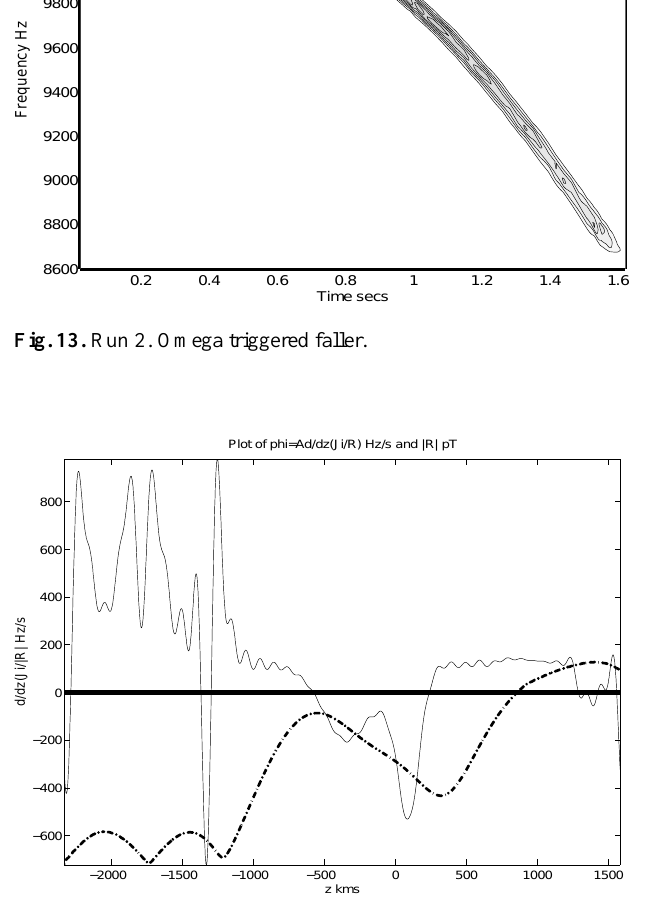
Fig. 14. Run 2. Plot of wave profile R = | E | (dashed line) and 8 (solid line) as functions of z at t = 1 . 0s. Note the pronounced region where 8 is negative and the fact that the wave profile extends further upstream (towards the transmitter) in the case of a faller GR.